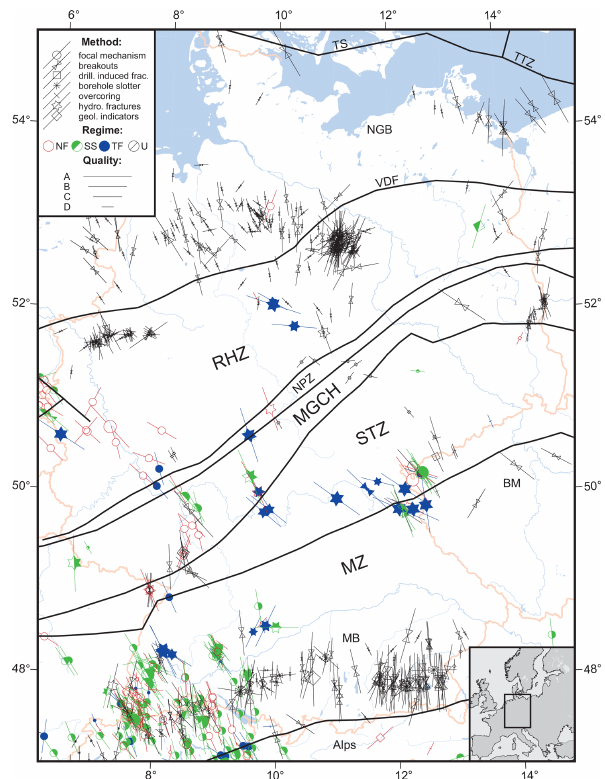
Figure 1. Stress orientation in the German Central Uplands with the basement structural elements (separated by black lines), po- litical boundaries (red) and major rivers (blue). Bars represent orientation of maximum horizontal compressional stress ( S Hmax ); line length is proportional to quality. Colours indicate stress regimes, with red for normal faulting (NF), green for strike– slip faulting (SS), blue for thrust faulting (TF) and black for unknown regime (U). The Variscan basement structures intro- duced by Kossmat (1927) are visualized; the regional segmenta- tion is as follows: BM = Bohemian Massif, MGCH = Mid-German Crystalline High, MZ = Moldanubian Zone, NPZ = Northern Pyl- lite Zone, RHZ = Rheno-Hercynian Zone, STZ = Saxo-Thuringian Zone, and VDF = Variscan Deformation Front. Other structures are as follows: MB = Molasses Basin; NGB = North German Basin, TS = Thor Suture, TTZ = Teisseyre–Tornquist Zone (redrawn after Franke, 2014; Grad et al., 2016).